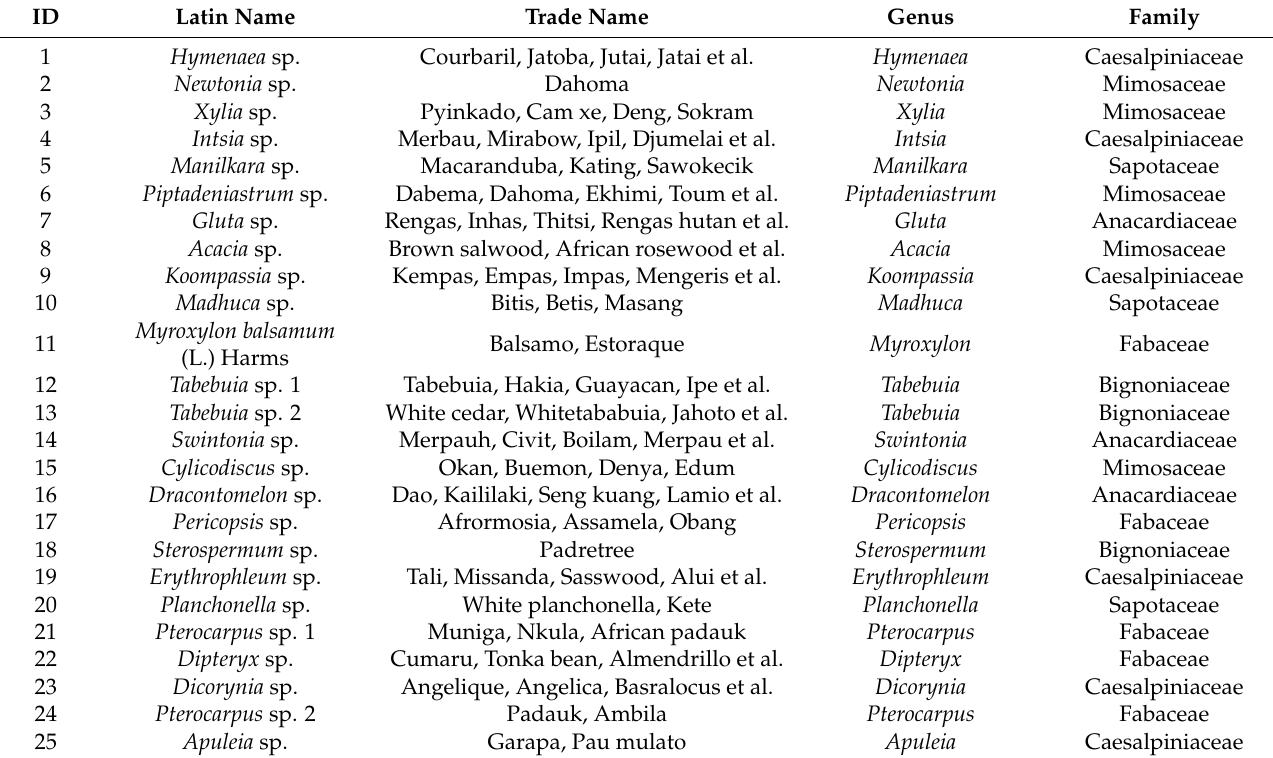
Table 1. Wood timbers used in the